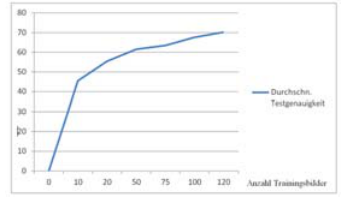
Figure 20: Average wrong classifications in % of each class for different number N of training images (classes 7 to 12) for segmented images (Source: Miller, 2014).